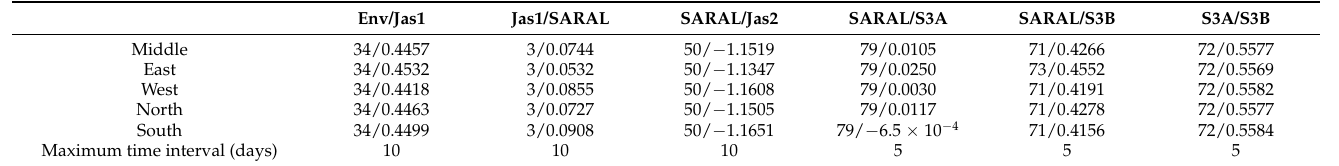
Table 2. Statistics of deviations between different satellites (number of used points/deviations